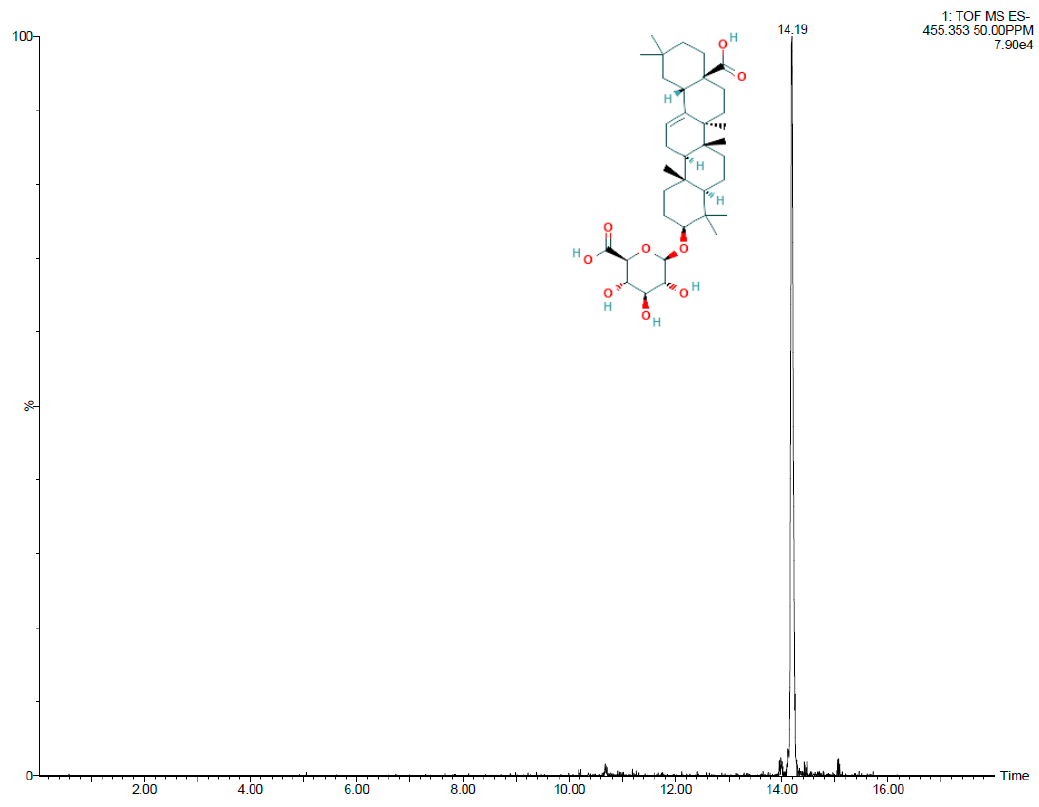
Figure 5. UPLC-HRMS Q-TOF spectra obtained from Salicornia exudates.